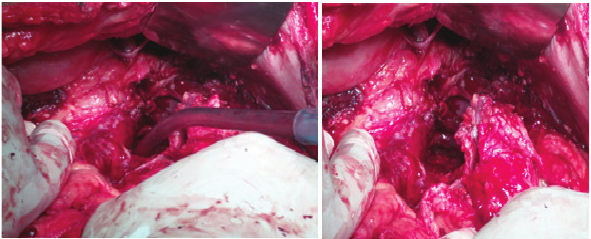
Figure Intraoperative photo of laparotomy necrosectomy and lavage after the failure of laparoscopic necrosectomy